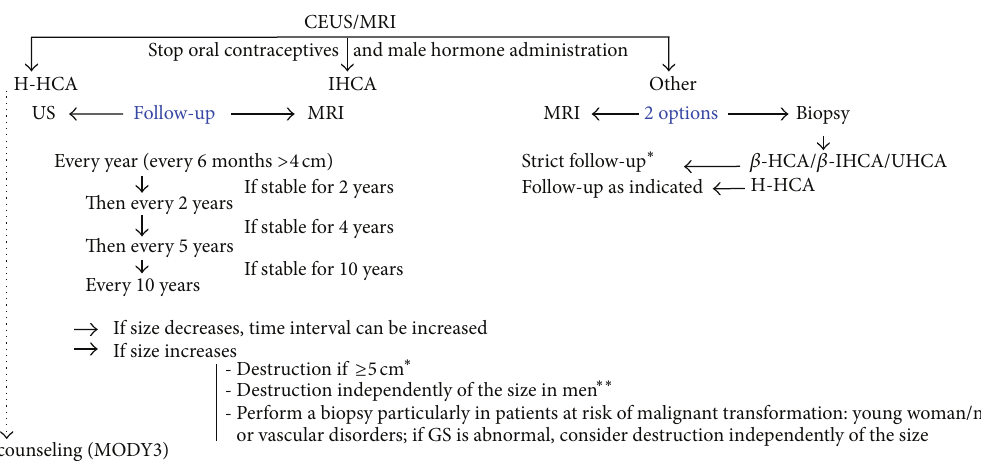
Figure 3: Management of HCA subtypes <